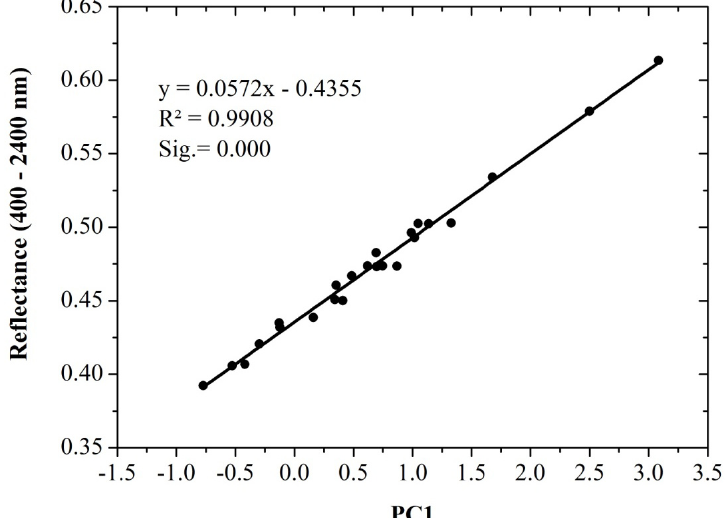
Figure 5. The relationship between the average soil reflectance in the 400–2400 nm range and the first principal components scores (PC1) for NaCl samples chemically treated with gypsum (TG).